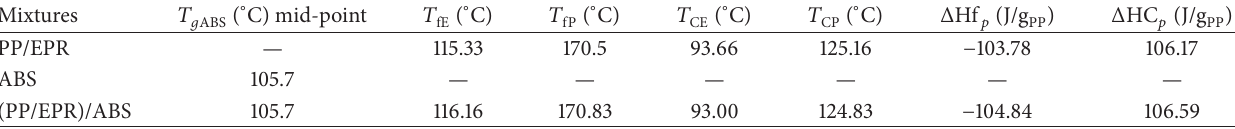
Table 6: Thermal characteristics of copolymers PP/EPR and ABS and their mixture (PP/EPR)/ABS. Mixtures